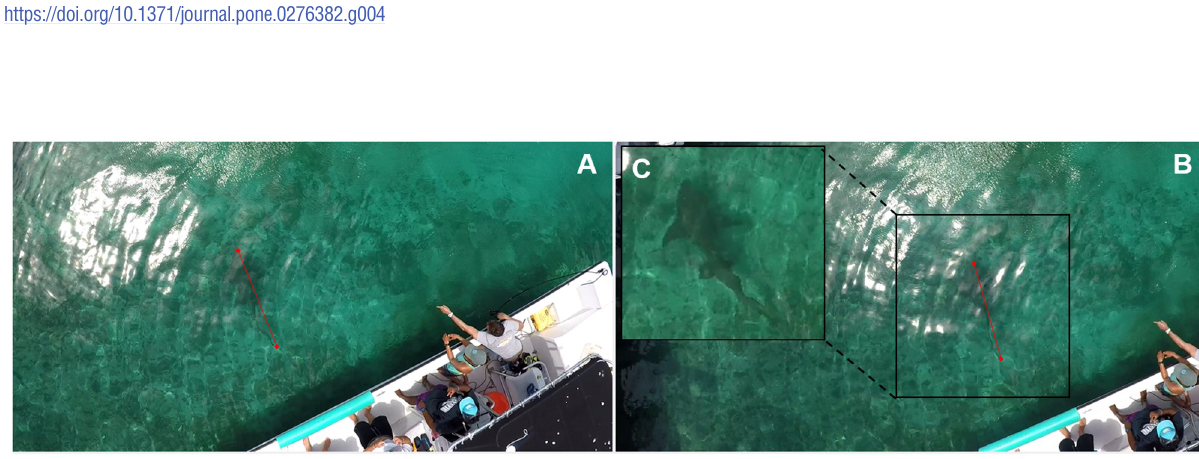
Fig 5. Stereo-video camera software interface. (A) Left and (B) right camera views of a nurse shark ( Ginglymostoma cirratum ) measured for total length, and (C) zoomed-in image of the right camera image of the shark. In (C), the photo has been enhanced for contrast and to sharpen edges to aid in shark visibility. Red lines indicate the measurement vectors for total